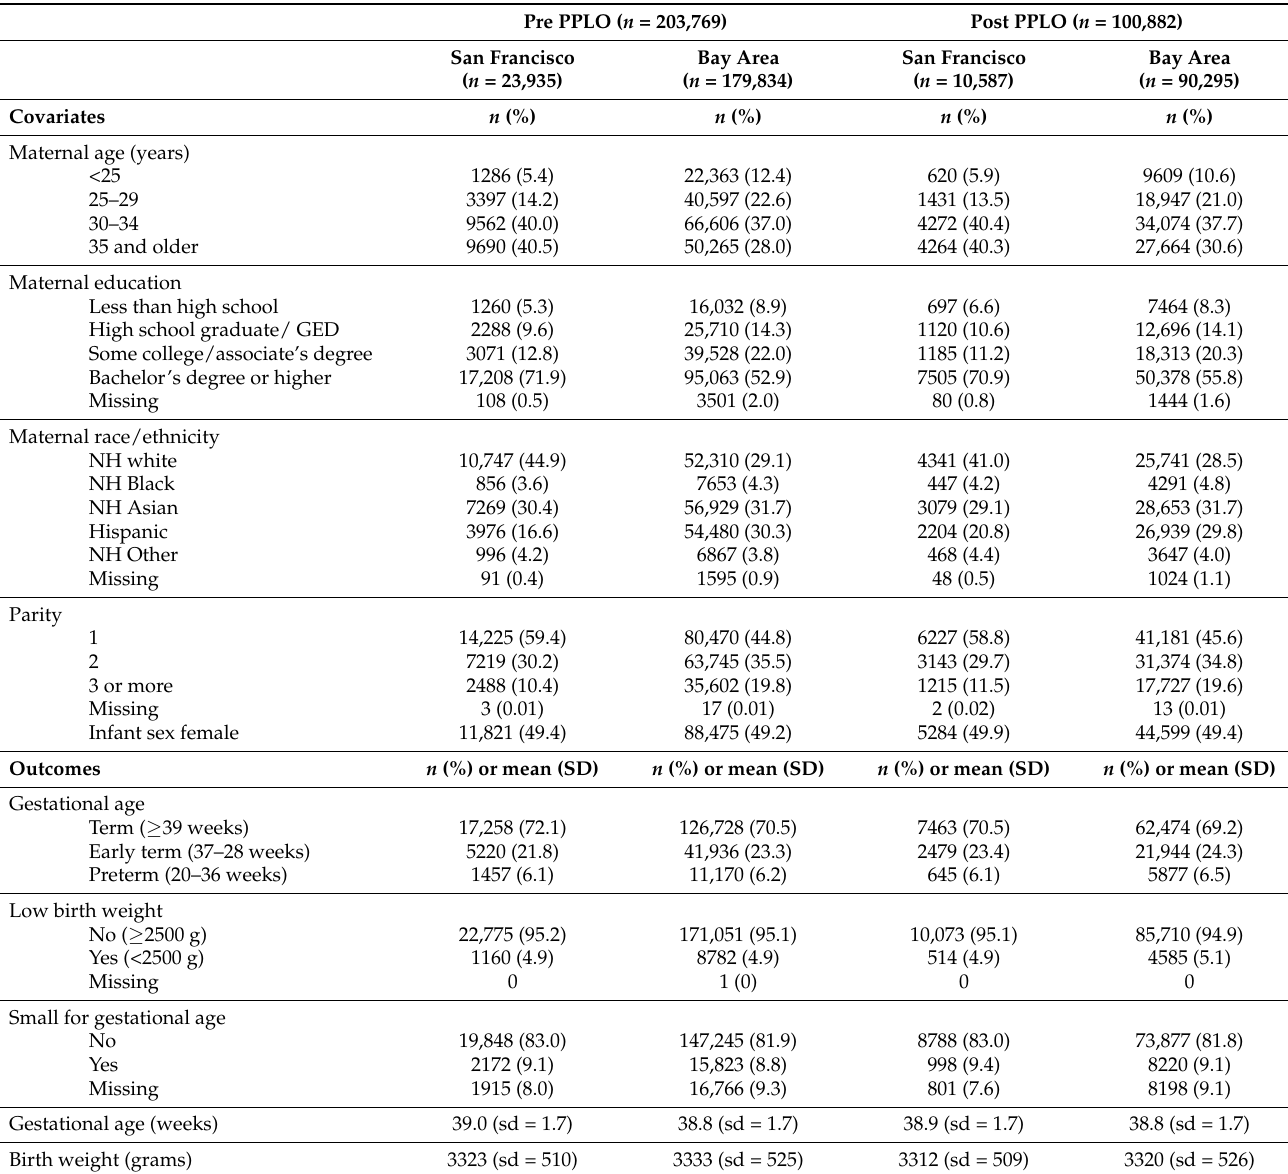
Table 1. Summary